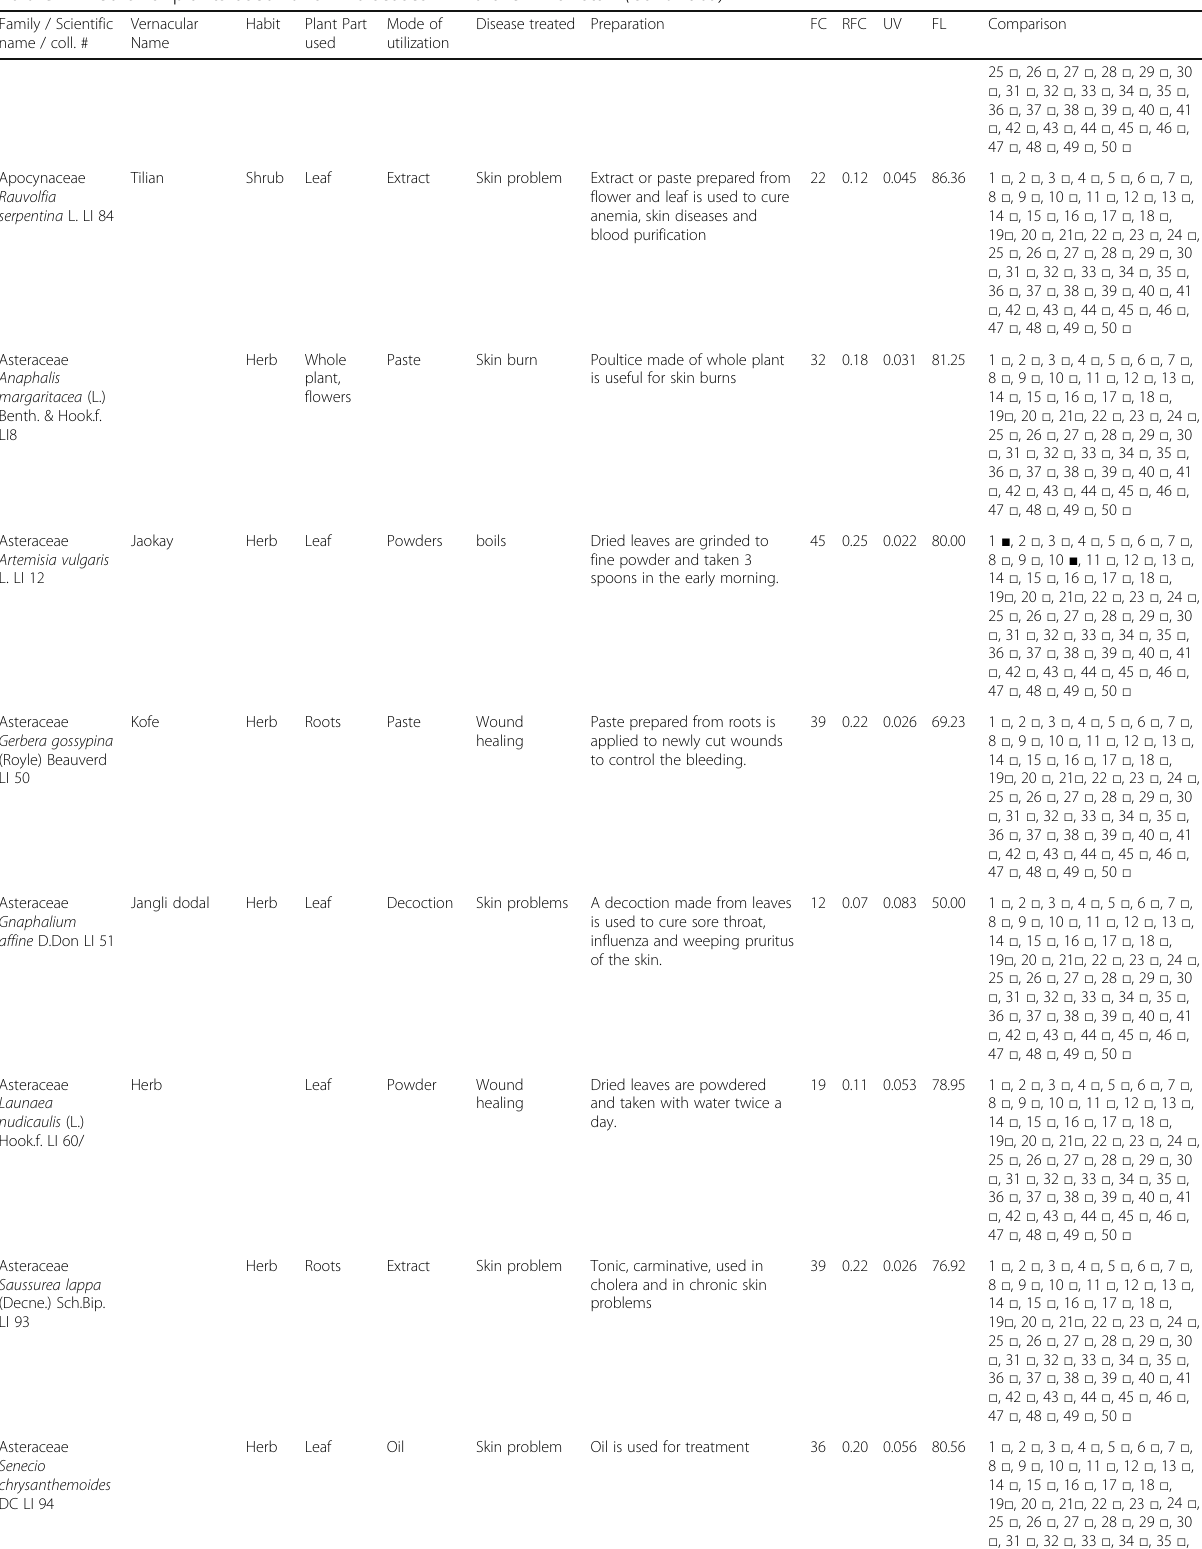
Table 2 Medicinal plants used for skin diseases in Northern Pakistan (Continued) Family / Scientific name / coll.